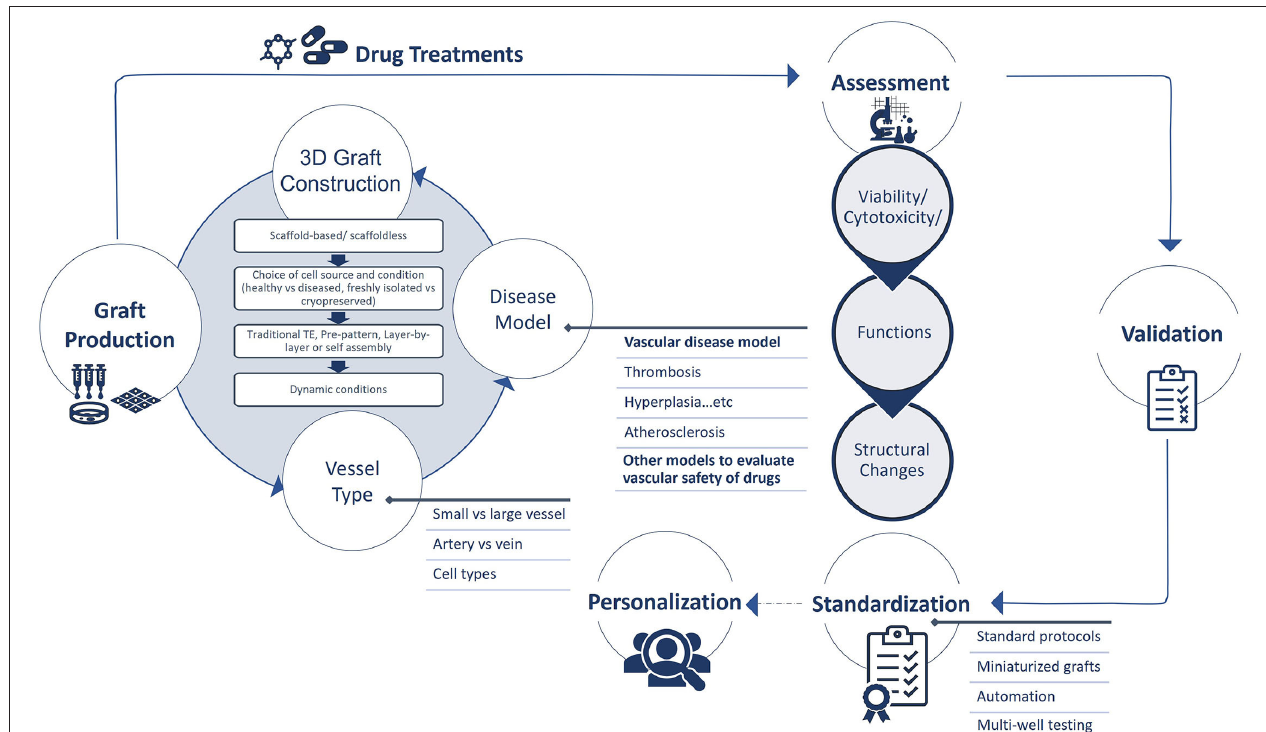
FIGURE 7 | Production, assessment, validation, standardization, and personalization of 3D tissue engineered vascular grafts for drug